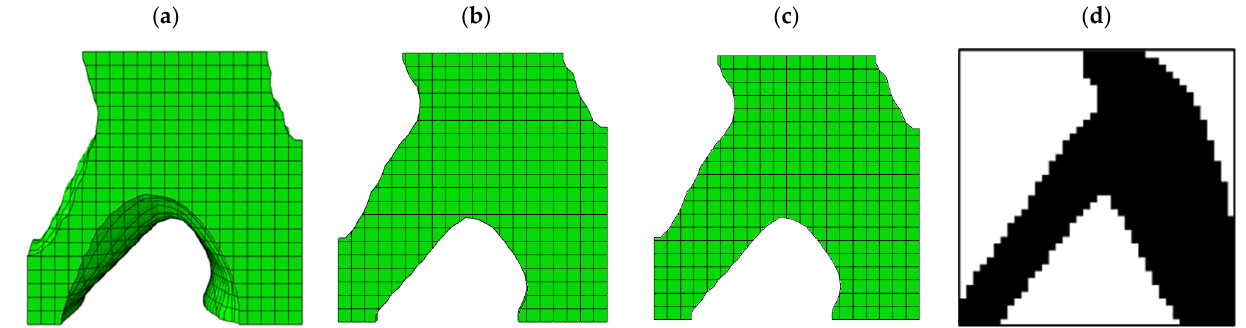
Figure 7. The comparison of the results obtained from ABAQUS software: ( a ) 3D model, ( b ) 3D model with low thickness, ( c ) 2D model, and ( d ) plus results of the MATLAB code.